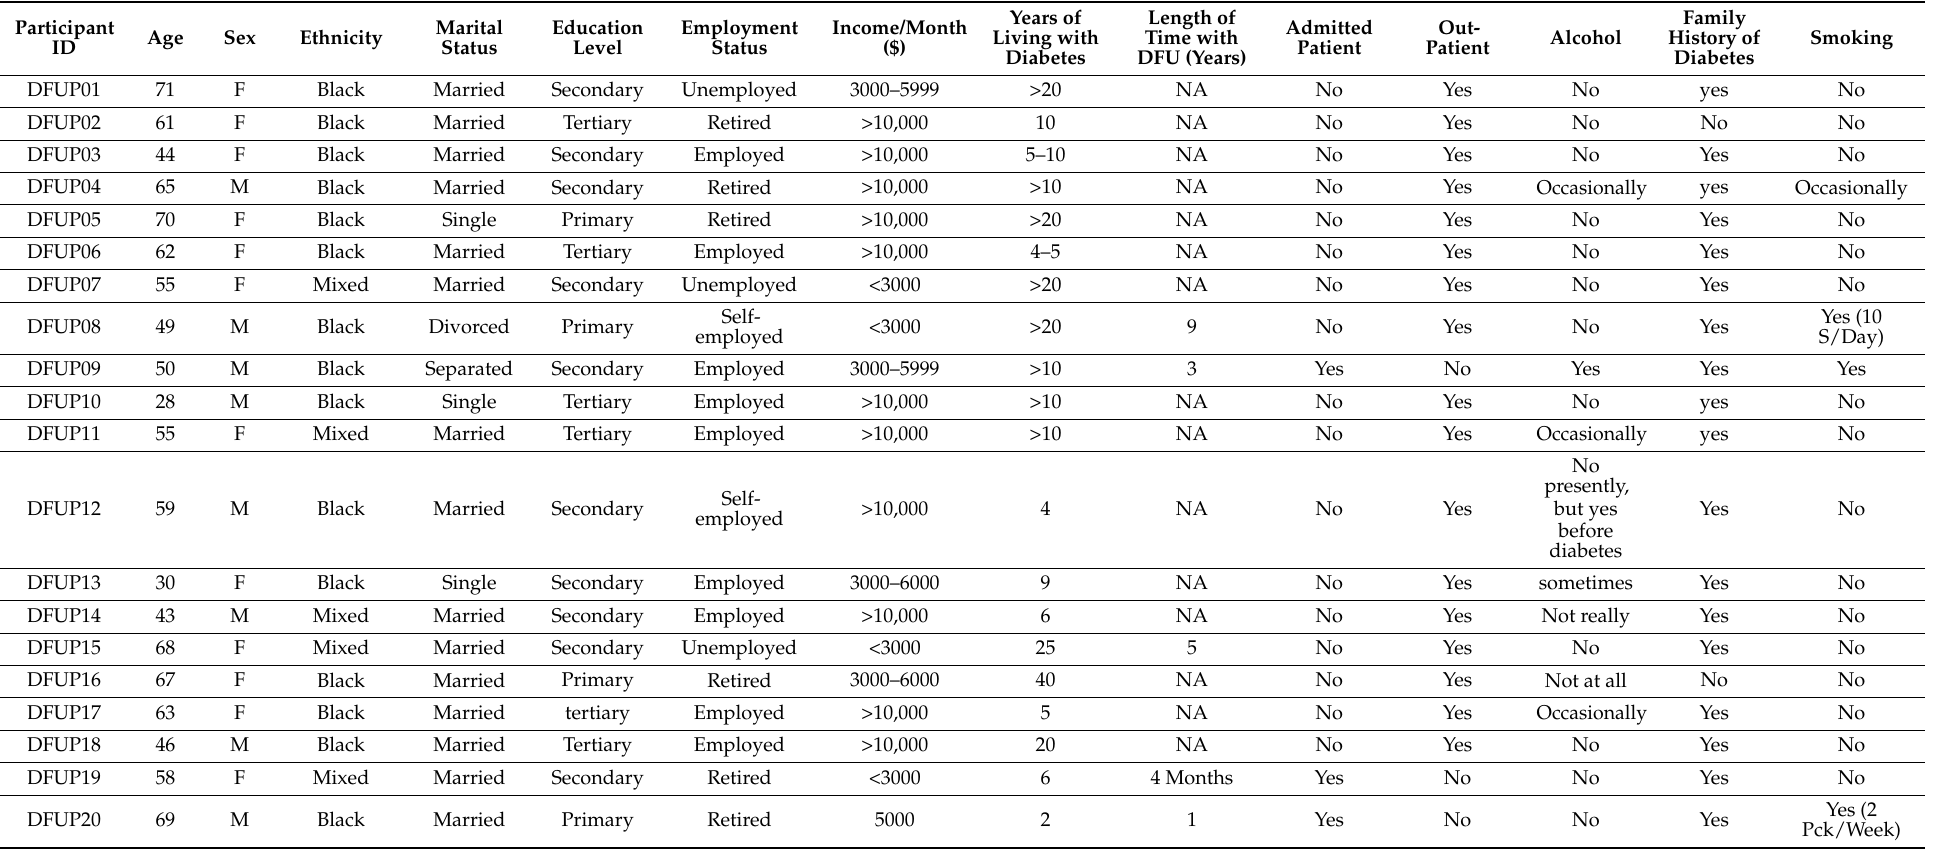
Table 1. Participants socio-demographic